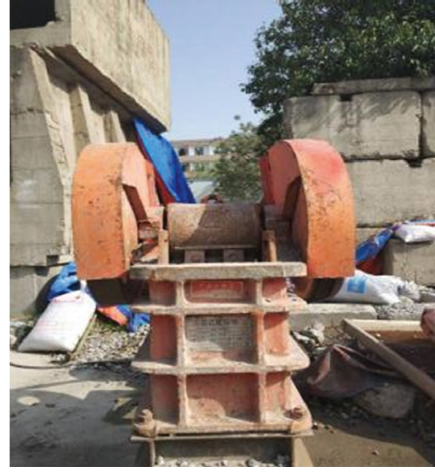
Figure 1: Jaw crusher.